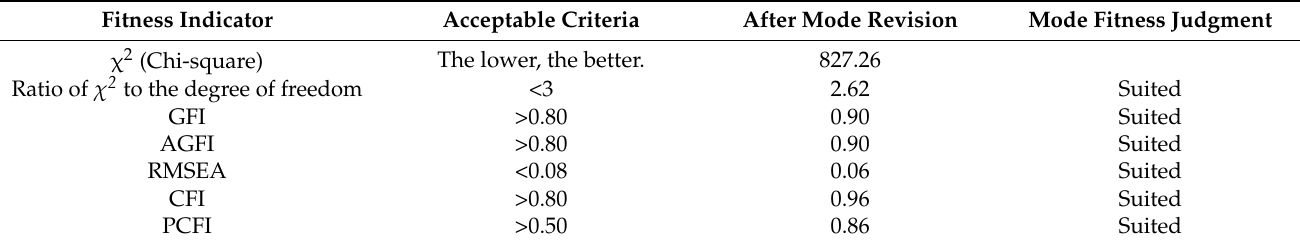
Table 9. Overall Fitness Analysis of the Research